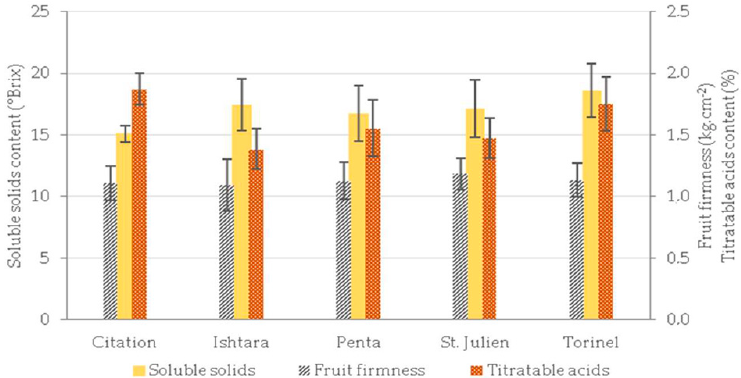
Figure 1. Average values of SSC ( ◦ Brix), titratable acids content (%) and fruit firmness (kg · cm − 2 ) for analyzed plum cultivars with Citation, Ishtara, Penta, St. Julien A and Torinel rootstock. The vertical lines represent the standard deviations.